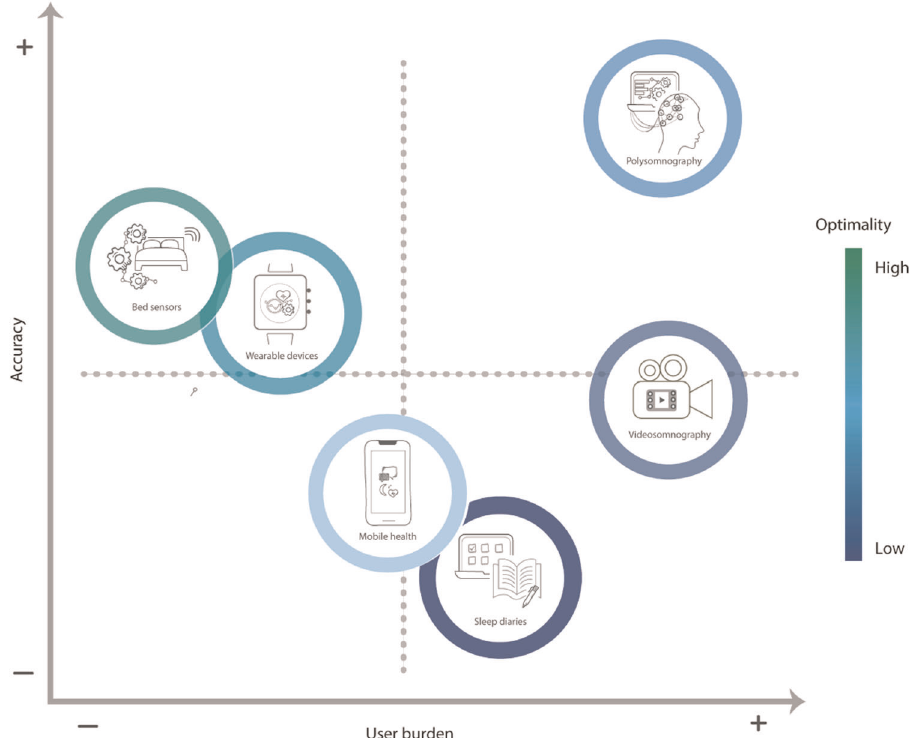
Fig. 3 Selected methods for the measurement of sleep and their accuracy and usability trade-off. This chart plots the accuracy of sleep- sensing methods at infering sleep-related metrics against their ease of use. For example, while polysomnography is considered the “ gold- standard ” technique to measure sleep, it is cumbersome and